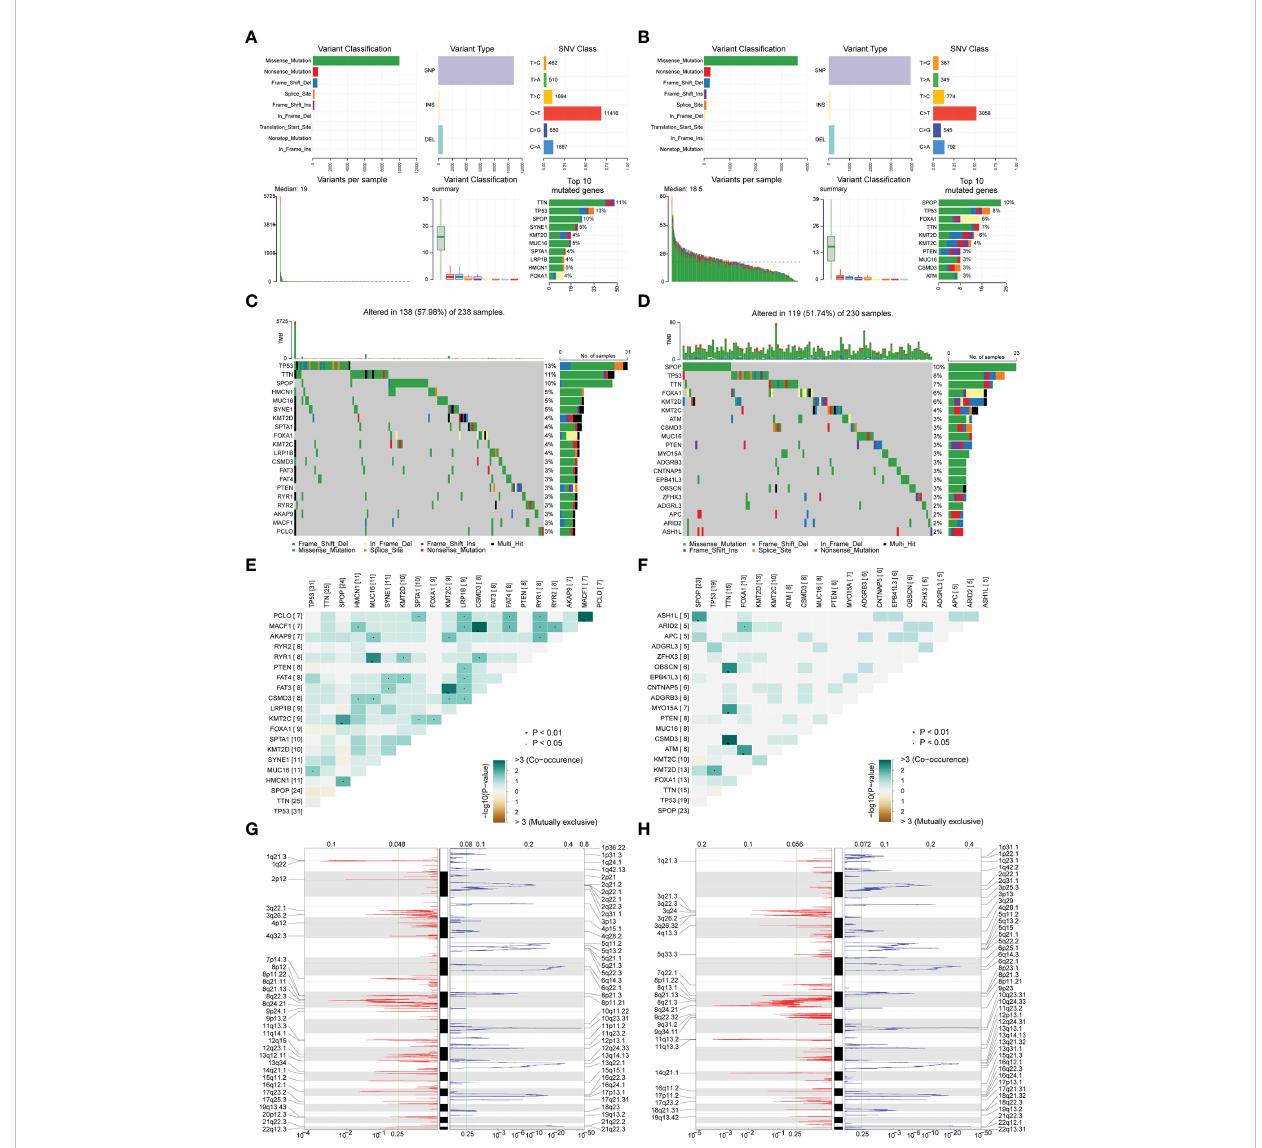
FIGURE 6 Correlation analysis of risk scores and genomic characteristics. (A, B) Summary data on mutation for patients with low-risk and patients with high- risk. (C, D) Statistics of top 20 mutant genes in patients with high-risk and patients with low-risk. Samples are ordered according to somatic nonsynonymous mutational burden and genes are ordered by mutation frequency, with various colors indicating different mutation types. The subsection above the legend shows mutational burden. (E, F) Demonstration of synergy and mutational relationships between mutated genes in patients with high-risk and patients with low-risk. (G, H) Identi fi ed genes with signi fi cant ampli fi cations and deletions in patients with high-risk and patients with low-risk. Q-value and change score of GISTIC2.0 (x-axis) versus genomic location (y-axis). Dashed lines indicated centromeres. The green line represents the 0.25 Q-value cut-off point for determining signi fi cance. *P <